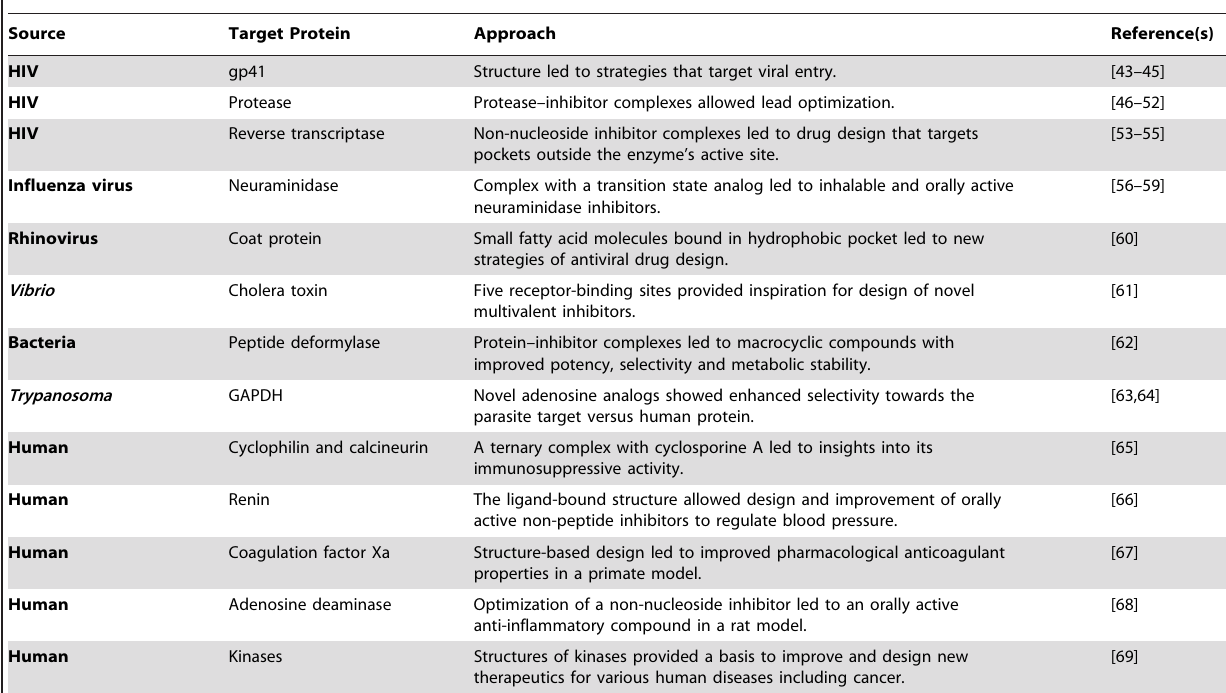
Table 1. Examples of how target protein structure can assist drug discovery and development.